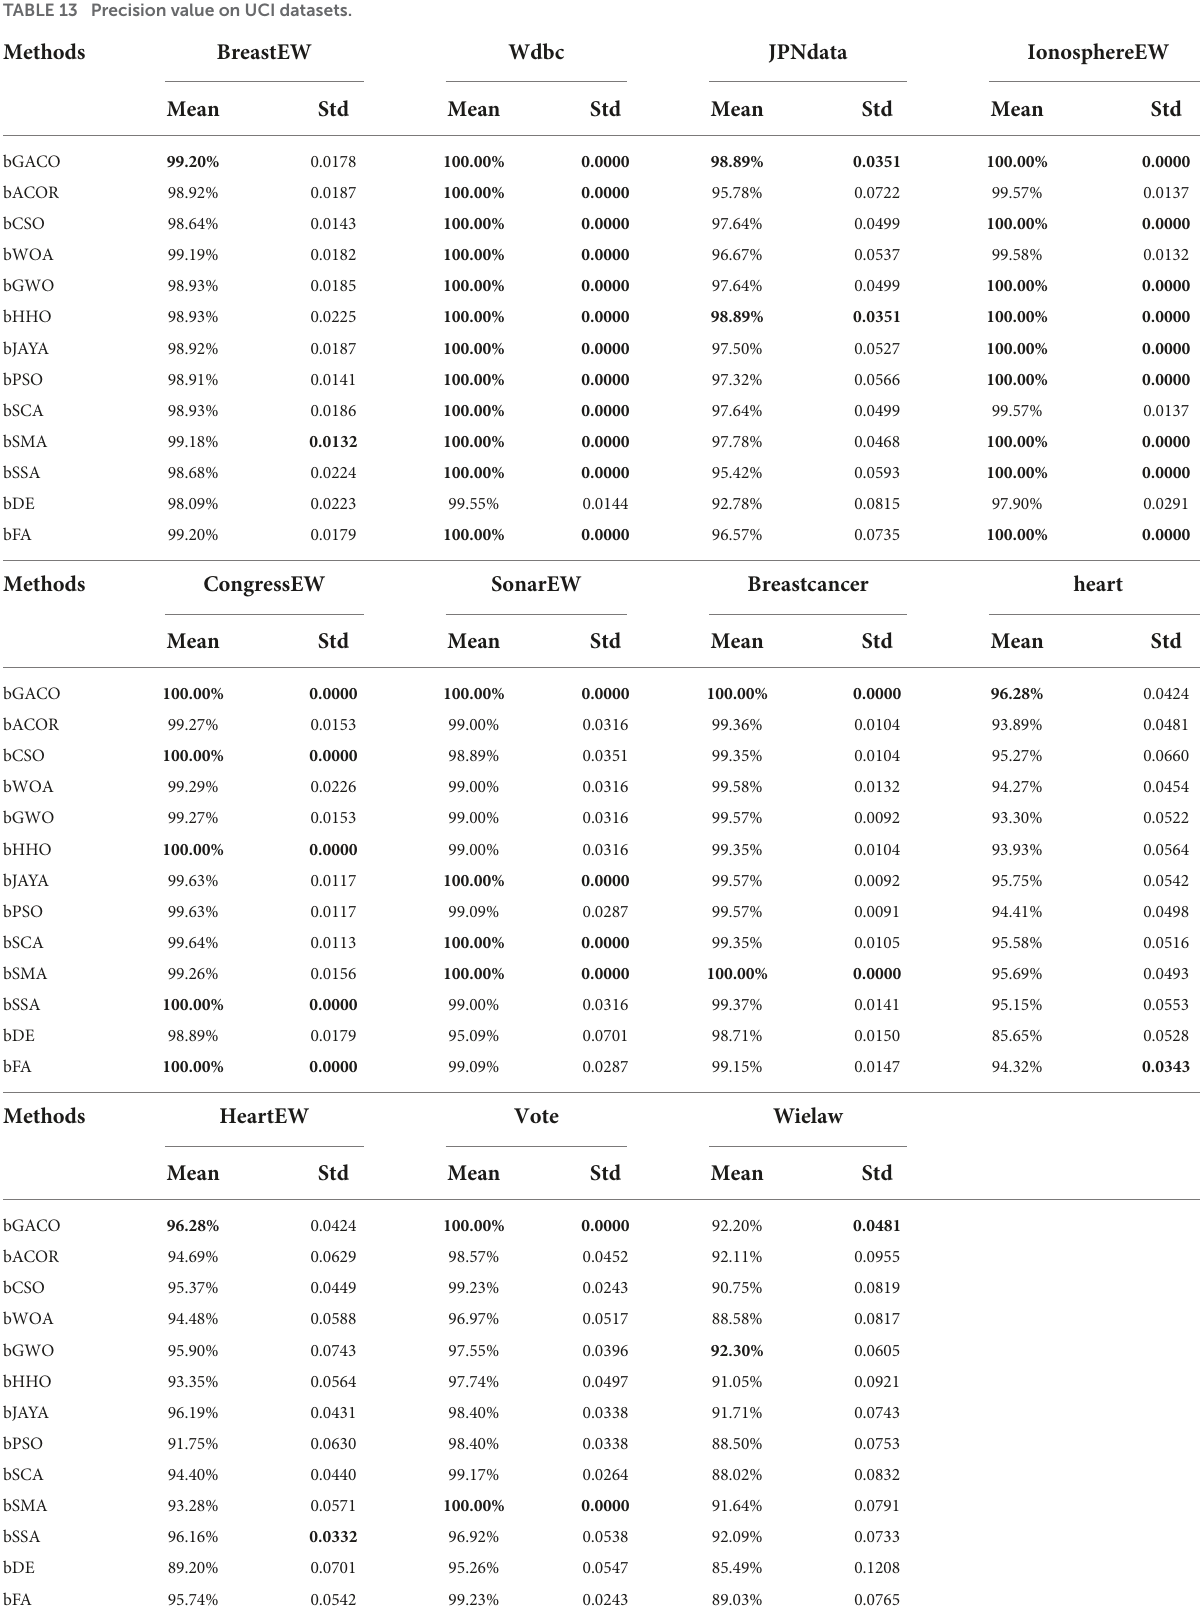
TABLE 13 Precision value on UCI